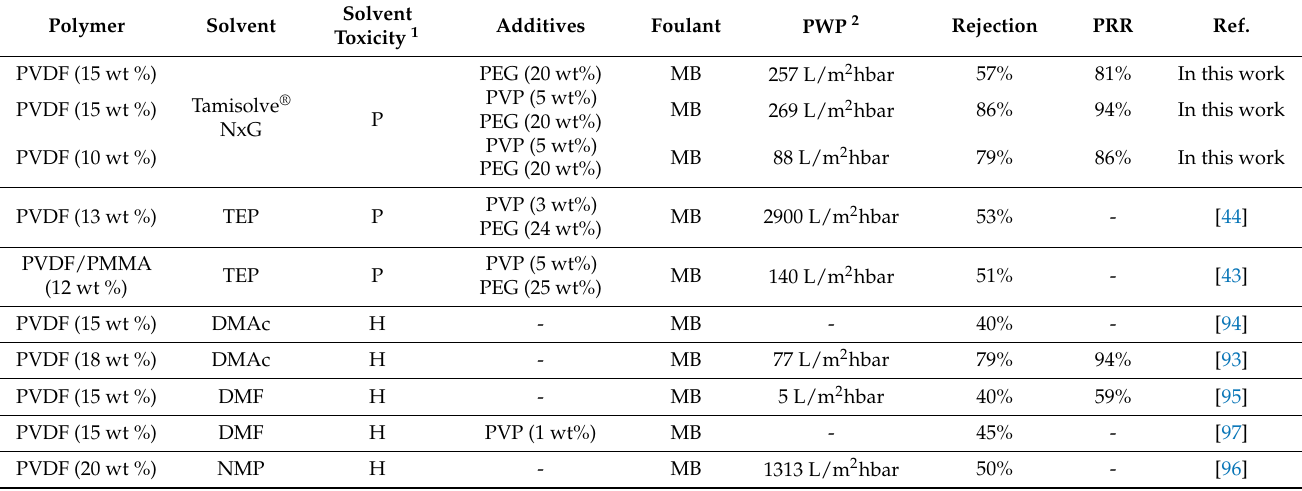
Table 5. Filtration performance of PVDF membranes prepared with emerging greener and conventional solvents (concentra- tion of MB may be different).